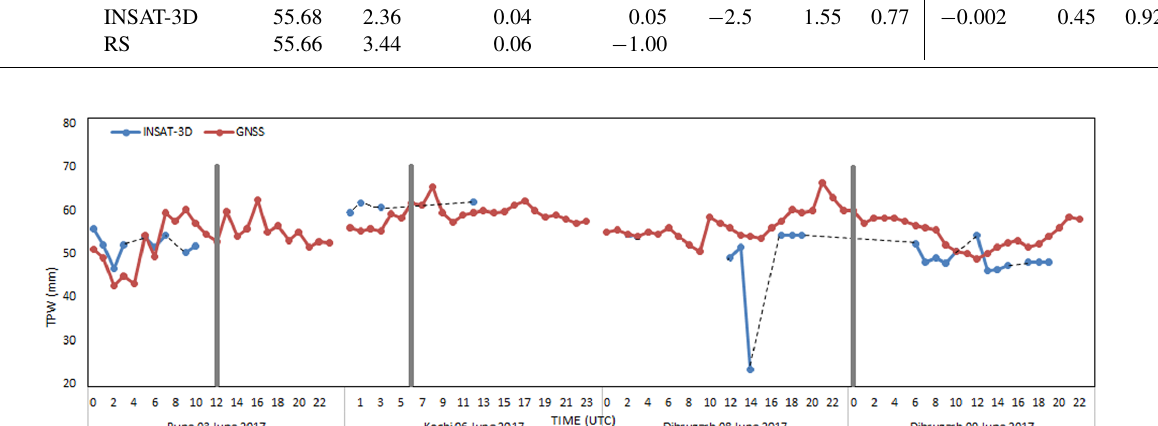
Figure 7. Thunderstorm weather events in Pune on 3 June 2017, Kochi on 6 June 2017 and Dibrugarh on 8–9 June 2017.